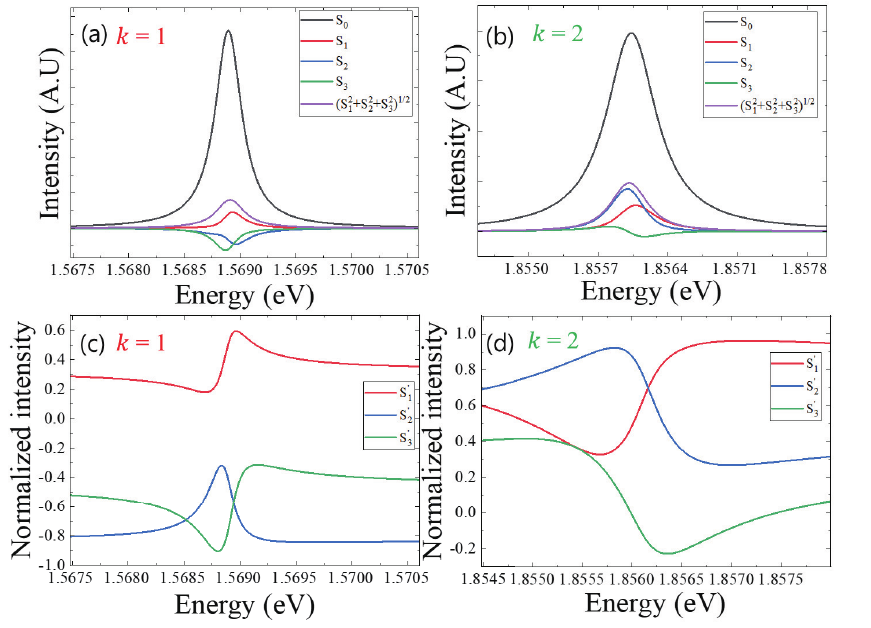
(cid:113) + S 2 + S 2 S 2 ) 2 3 1 (cid:48) (cid:48) = S = S = S 2 ⁄ S , S 3 ⁄ S ) 1 ⁄ S , S 2 3 1